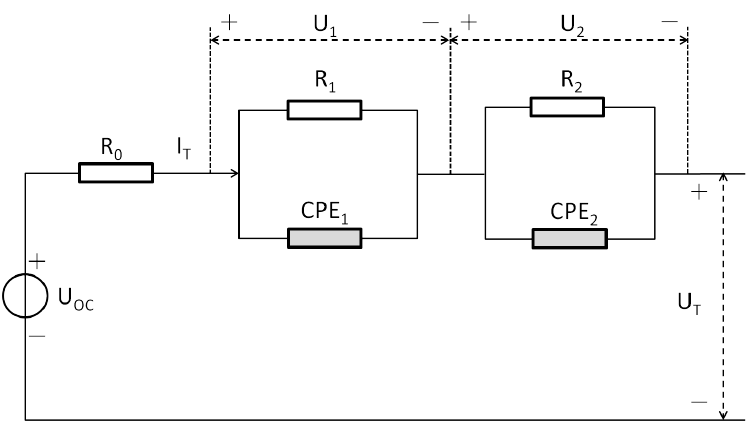
Figure 1. The schematic diagram of the fractional 2nd-order RC